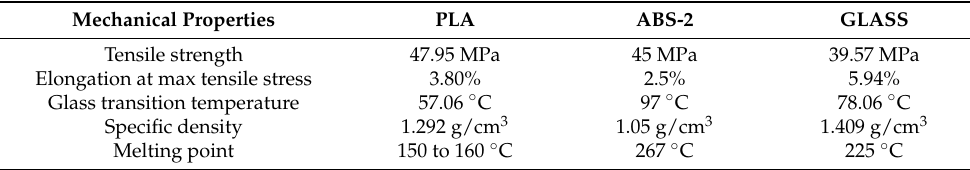
Table 1. Mechanical properties of 3D printer